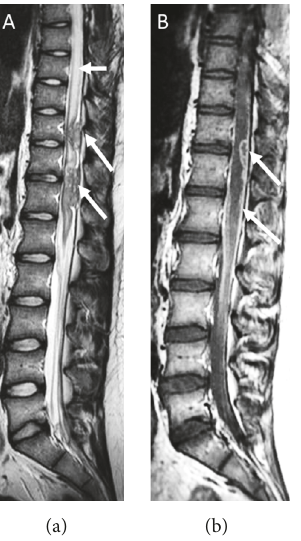
Figure 3: Sagittal FSE T2 (a) and postcontrast T1 (b) MR images of thoracolumbar spine at about 3 months of first admission. Spinal cord edema (Arrow 1). Diffuse nodular leptomeningeal and dural disease with ring enhancing abscesses (Arrow 2).